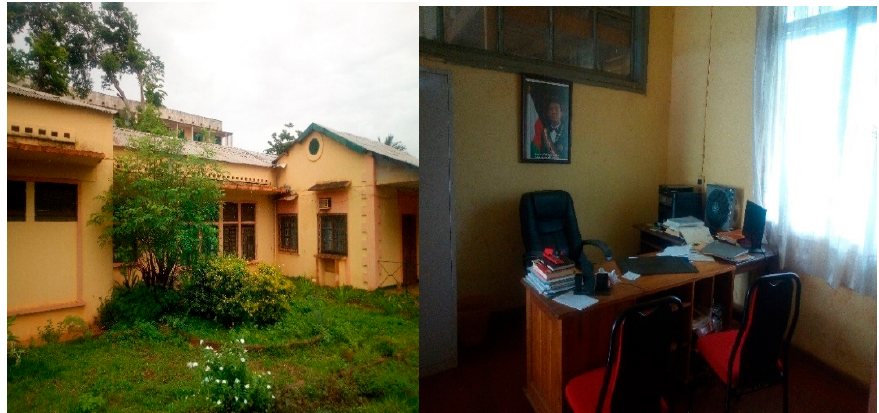
Figure 2. East facade of the studied office building.